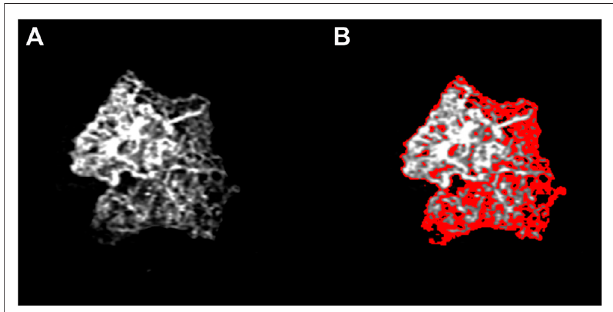
FIGURE 1 | Identi fi cation of low MNV re fl ectivity signal. This sample image shows that the regions of low re fl ectivity are located at the edge of the MNV network (A) , as high-lighted in red (B) . The distribution of the low re fl ectivity signal signi fi cantly affects the changes in MNV size detectable over the follow-up.